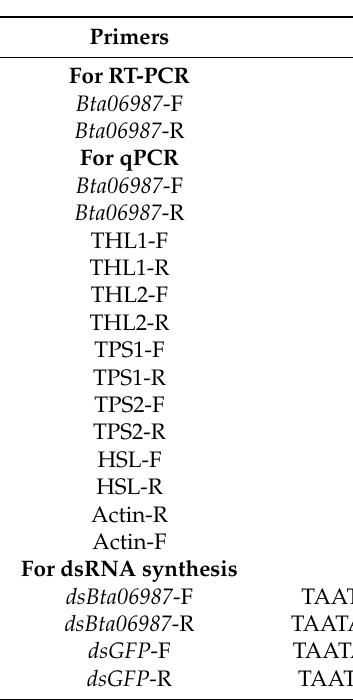
Table 1. Primers used in the